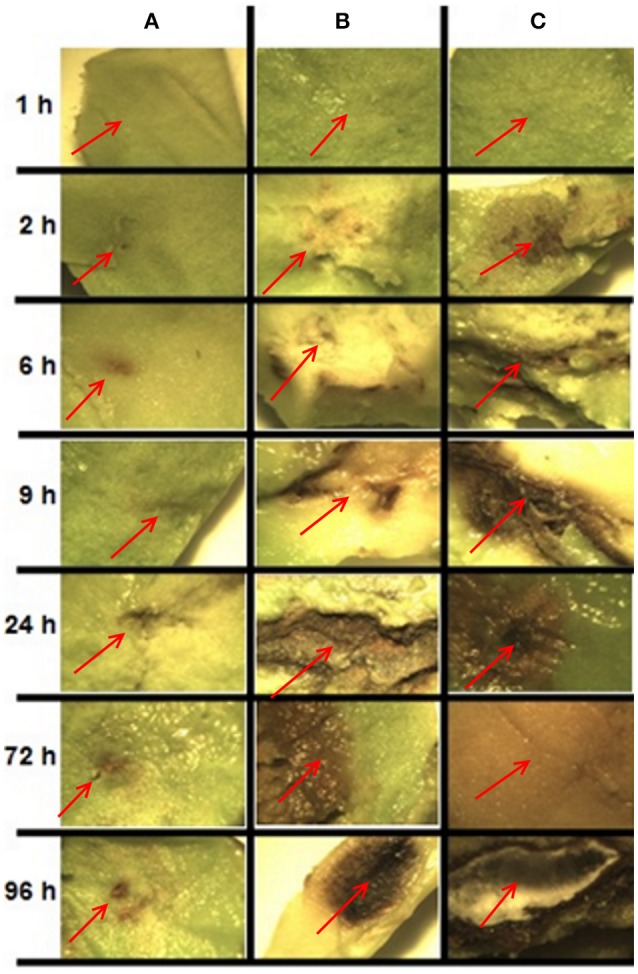
Development of infection caused by inoculation of C. gloeosporioides in fruits at different stages of maturity and at different post inoculation times. Each panel shows the pulp of avocado fruit of the area around the inoculation site. (A) Physiological maturity, (B) intermediate maturity, (C) consumption maturity. The red arrow indicates the inoculation site.